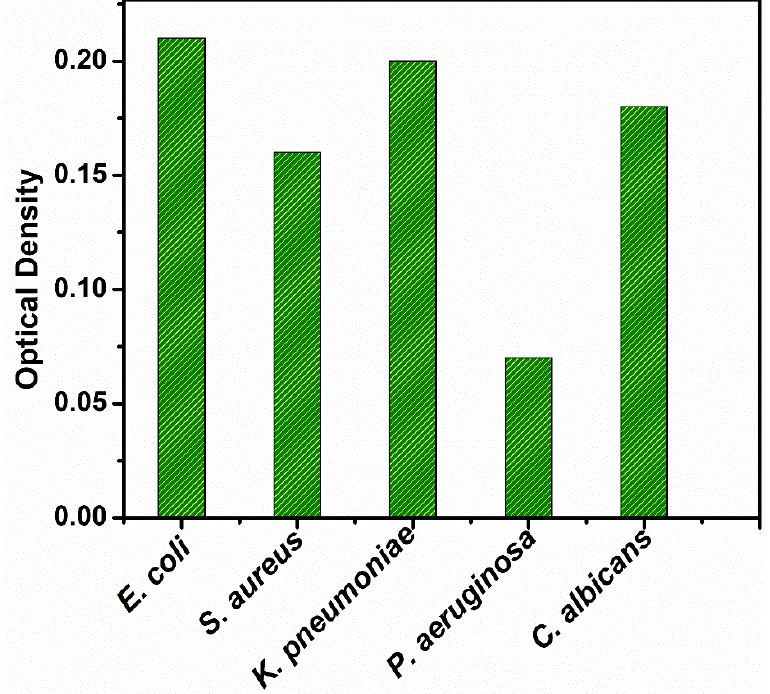
Figure 6. A comparative analysis on antibacterial activity of silver nanoparticles against E. coli, S. aureus, K. pneumoniae , P. aeruginosa, and C. albicans